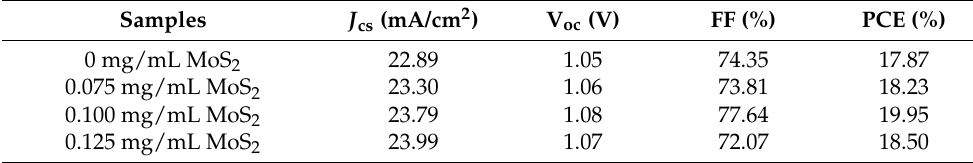
Table 2. Relevant device parameters obtained from J-V curves.